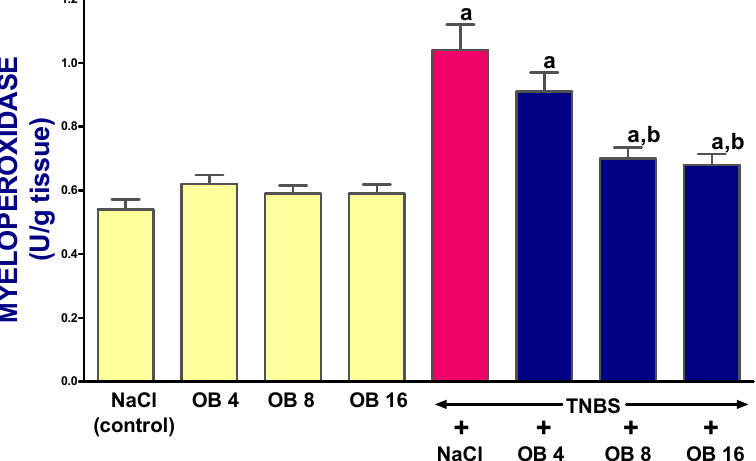
Figure 7. Effect of saline (NaCl) or obestatin given at doses of 4 nmol/kg (OB4), 8 nmol/kg (OB8), or 16 nmol/kg (OB16), and induction of TNBS-induced colitis on myeloperoxidase activity in colonic mucosa. Mean ± SEM. n = 10 in each group of animals. a p < 0.05 when compared with control; b p < 0.05 when compared with colitis + NaCl.